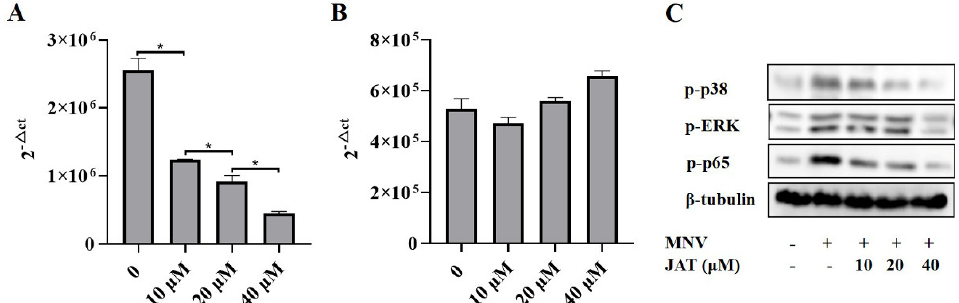
Figure 5. JAT inhibits MNV replication. The cell culture supernatants of RAW264.7 macrophages infected with MNV for 24 h and treated with JAT for 48 h were collected. ( A ) MNV RNA was extracted from the collected cell supernatant and the VP1 RNA level was tested by qRT-PCR. The cell culture supernatants and cell lysates of the RAW264.7 macrophages infected with MNV for 24 h and treated with JAT for 24 h were collected. ( B ) MNV RNA was extracted from the collected cell supernatant and the VP1 RNA level was tested by qRT-PCR. ( C ) Cell lysates were immunoblotted for phosphorylated MAPKs (p38 and ERK), p65 and β -tubulin. * p <